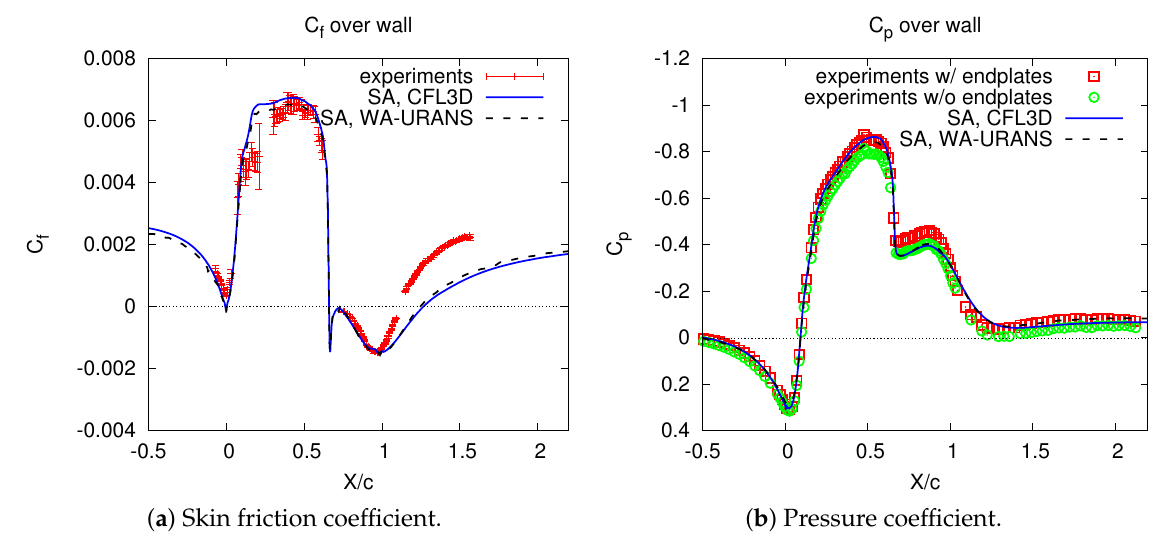
Figure 6. WA-URANS of NASA hump flow: skin friction and pressure coefficients over the bottom wall. Comparison is made with experimental data [61] and results by NASA CFL3D code supplied with SA model [62].